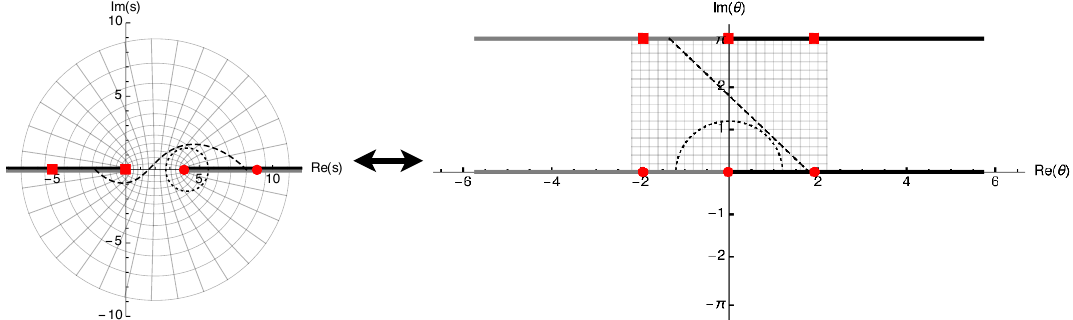
Figure 1 . Illustration of the conformal map in eq. (2.8). The complex s -plane, the left plot, is mapped into the complex (cid:18) -strip Im (cid:18) 2 (0 ; (cid:25) ), right plot. We have also depicted the mapping of a dashed curve, a dotted curve and a gray